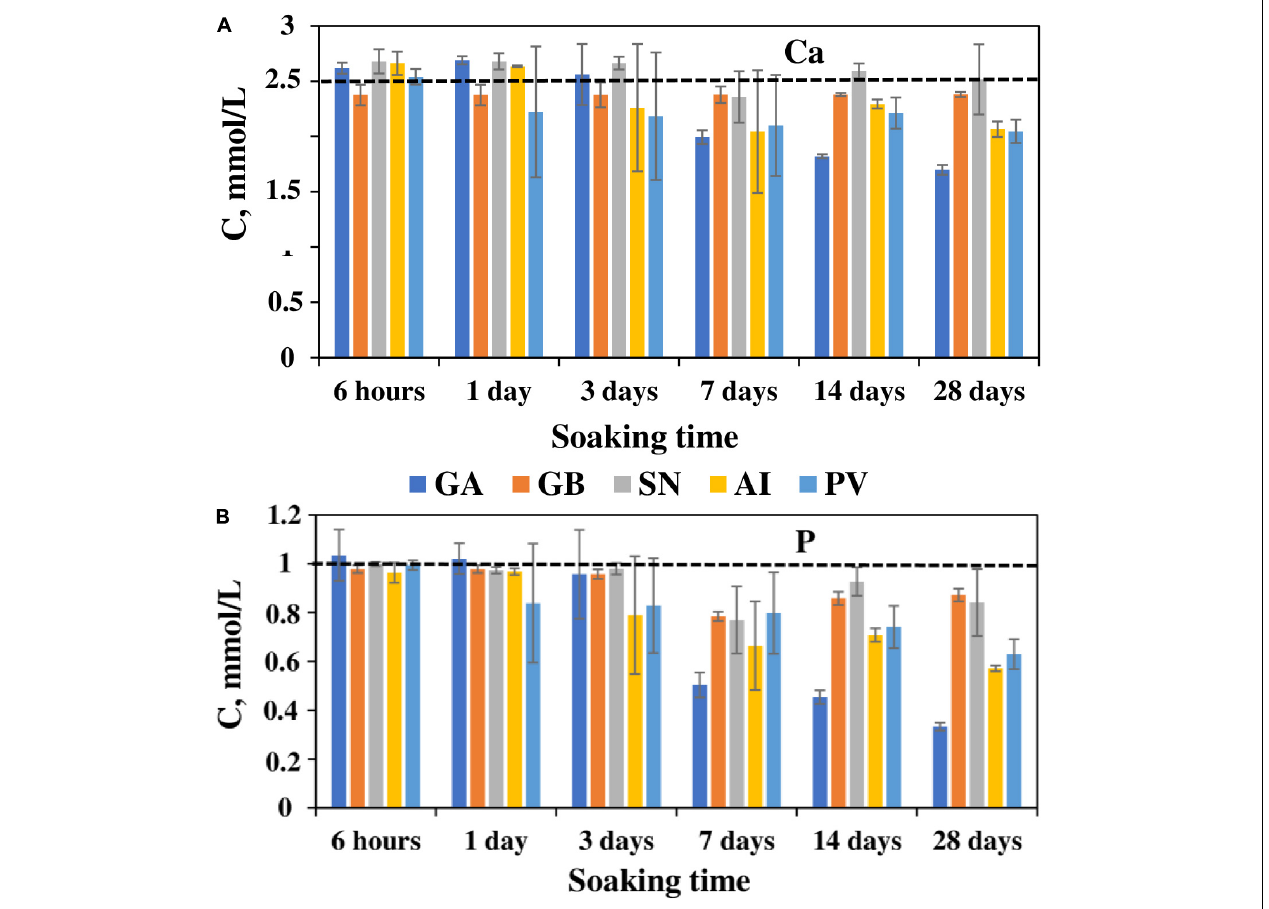
FIGURE 3 | Changes in Ca (A) and P (B) concentrations in the SBF solutions after immersion of the different biosilicas during 28 days.